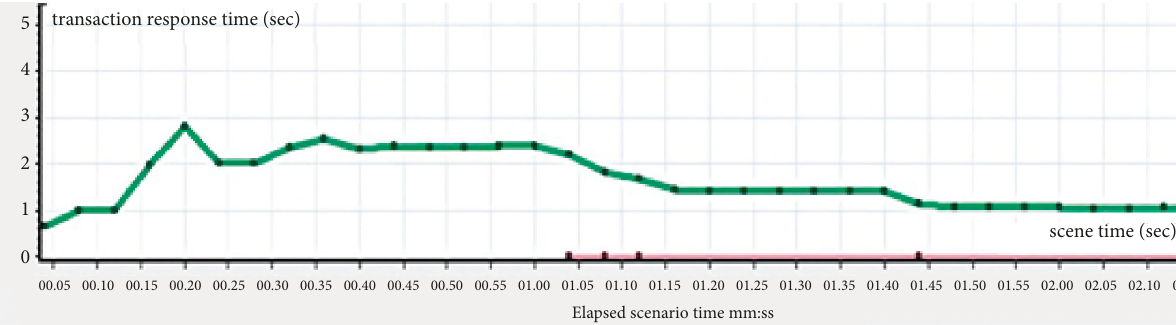
Figure 7: Response spectrum of automatic expansion system.